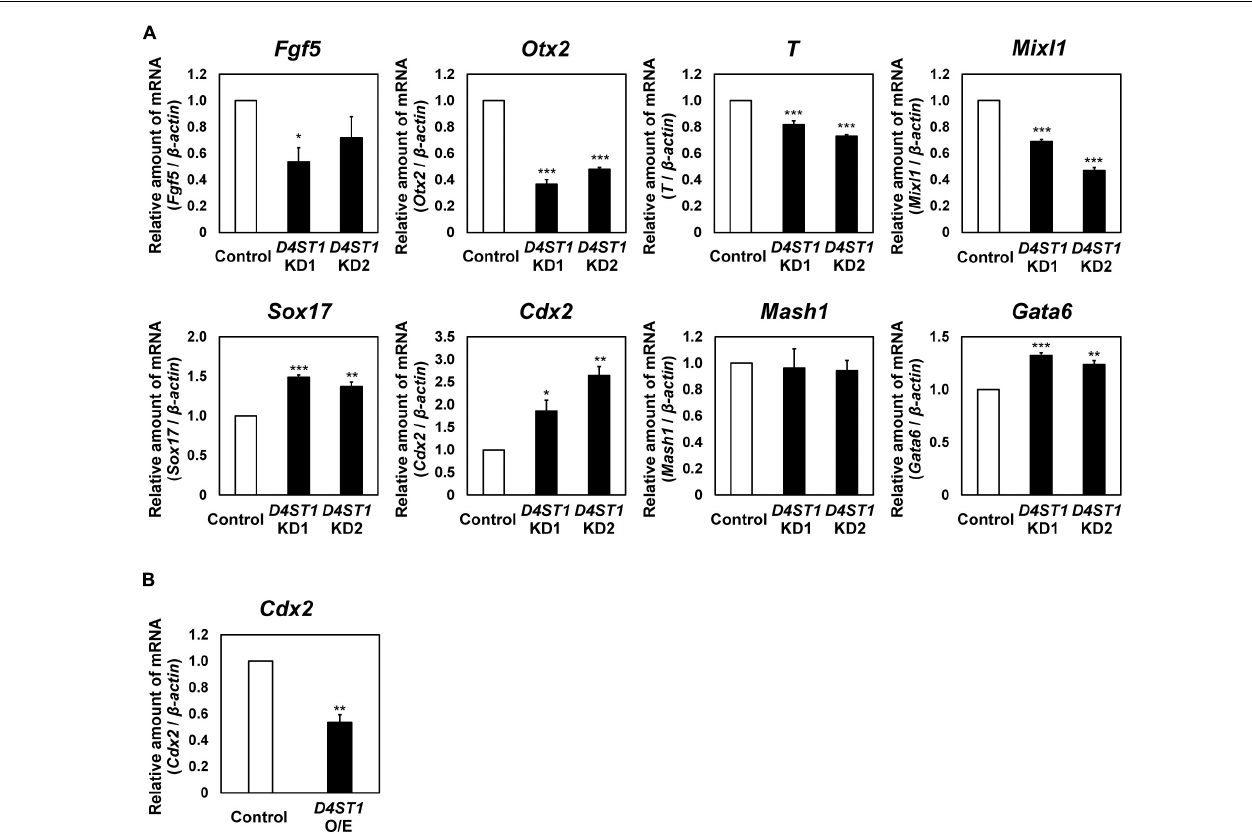
FIGURE 2 | Endodermal differentiation of mESCs is induced by D4ST1 KD. (A) Real-time PCR analysis of differentiation markers in D4ST1 KD at TF day 4. The amounts of differentiation marker mRNAs ( Fgf5 , Otx2 , T , Mixl1 , Sox17 , Cdx2 , Mash1 , and Gata6 ) were normalized to that of β -actin mRNA and are shown relative to the control (set to 1). (B) Real-time PCR analysis of Cdx2 in D4ST1 O/E at TF day 2. The amount of Cdx2 mRNA was normalized to that of β -actin mRNA and is shown relative to the control (set to 1). The values shown are means ± SD ( N = 3). Those significantly different to the control by Dunnett test (A) or unpaired two-tailed Student’s t -test (B) are indicated as follows: *** p < 0.001; ** p < 0.01; * p <